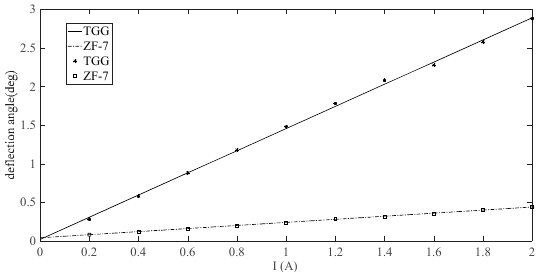
Figure 2. Faraday rotation experiment curves.